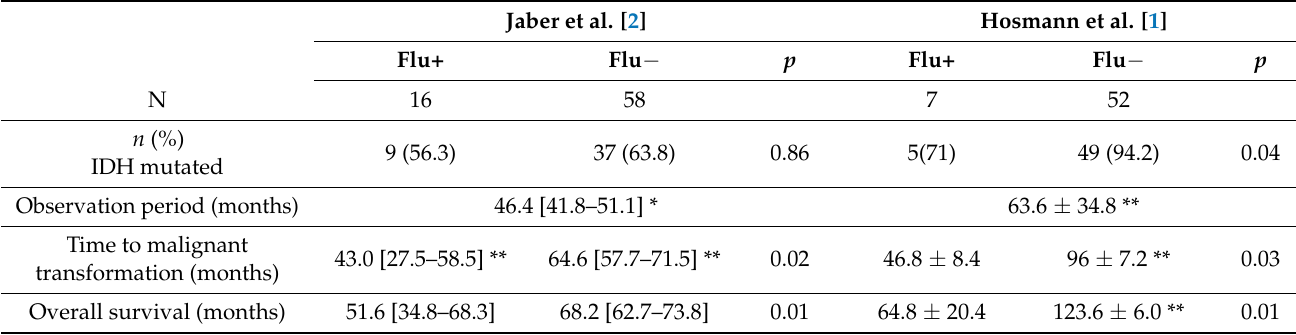
Table 1. Comparison between outcome data regarding fluorescing and non-fluorescing low-grade glioma after surgery from Jaber et al. [2] and Hosmann al. [1]. Note higher fraction of IDH-mutated tumors in Hosmann’s